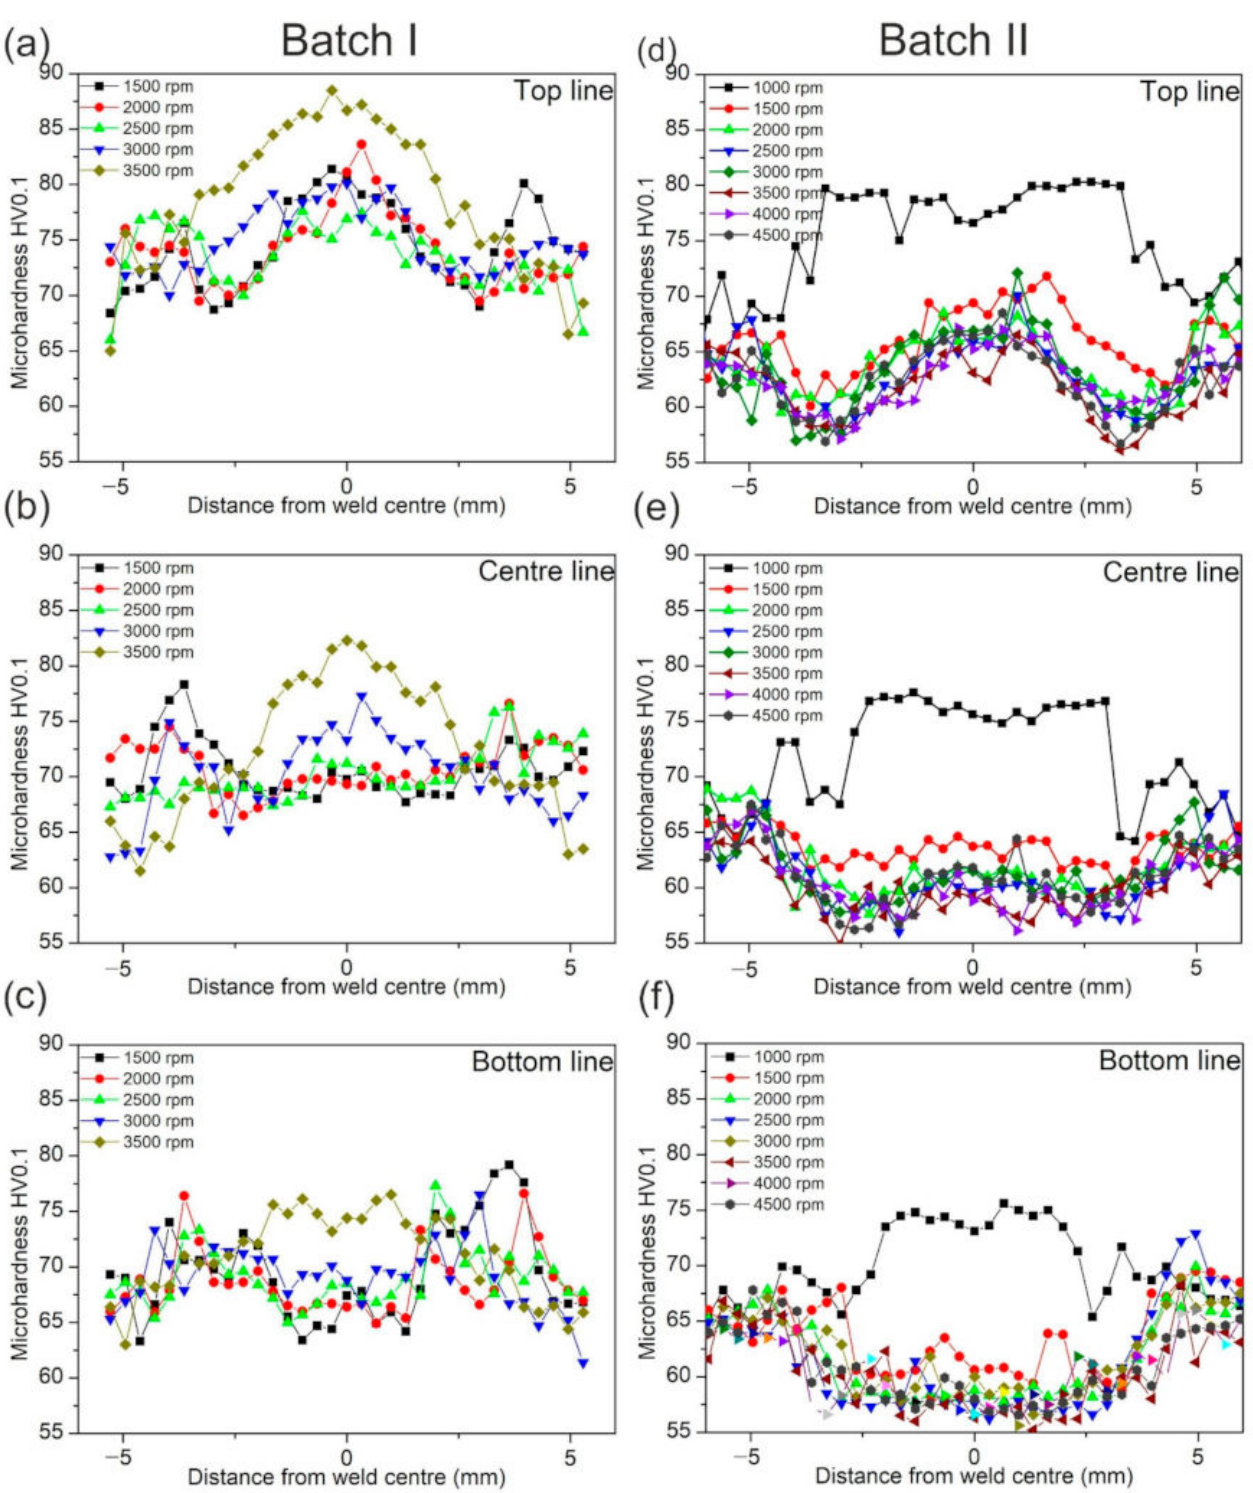
Figure 12. Microhardness profile measured at the weld cross-sections: ( a ) hardness profiles from the batch I in the top line (0.9 mm from the bottom of the sample); ( b ) in the middle line (0.6 mm from the bottom of the sample) ( c ) in the bottom line (0.3 mm from the bottom of the sample); ( d ) hardness profiles from batch II in top line; ( e ) in the middle line; ( f ) bottom